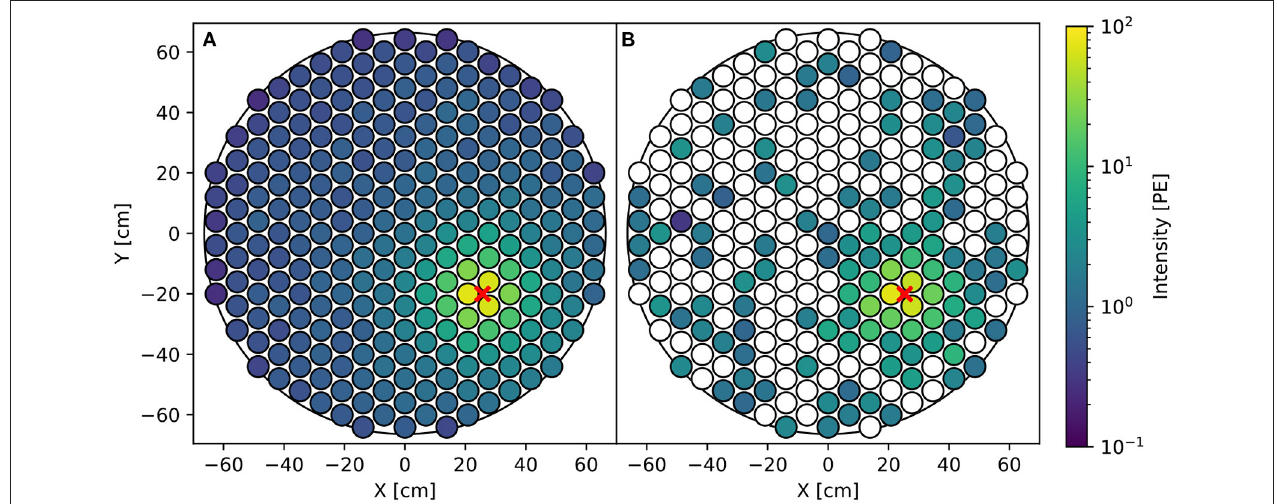
FIGURE 2 | (A) Average simulated S2 pattern. (B) A single simulated S2 pattern. S2s are simulated assuming 20 electrons are extracted into the gaseous xenon at the location of the red marker. The averaged S2 pattern is ideal which allows us to infer the position perfectly, while the actual S2 pattern contains fluctuations,